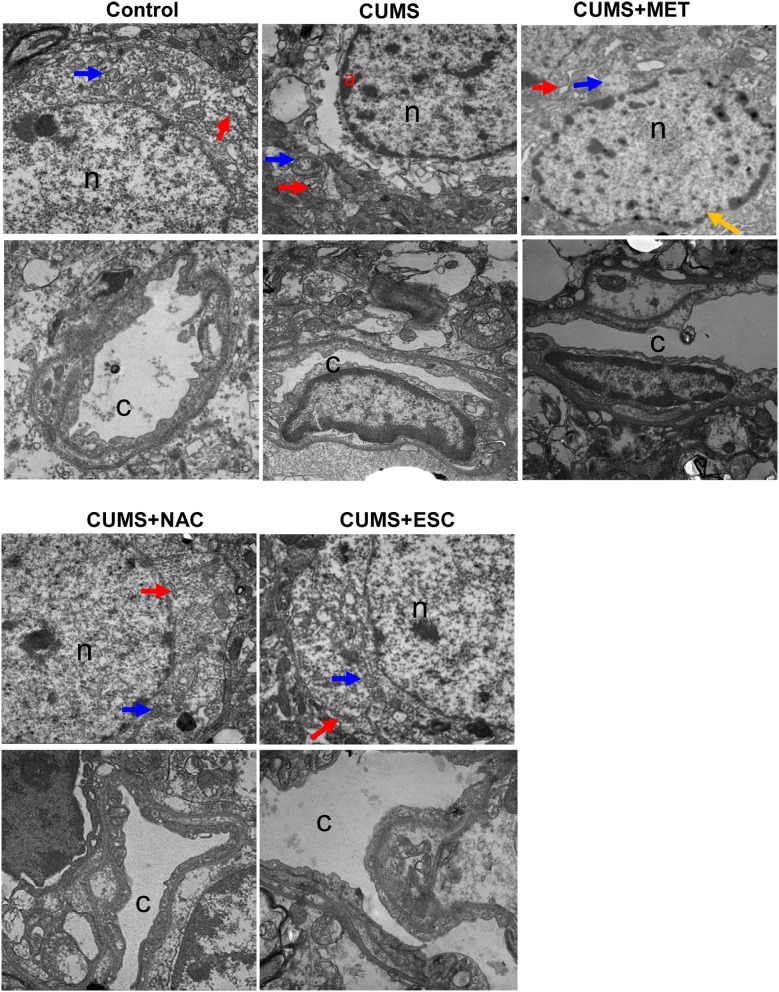
Electron microscope observation of cerebral cortex and hippocampus of rats in each group (×2500). “n” represents for the nucleus, “c” represents for the capillaries, “a” represents for chromatin concentration and edge polymerization, the blue arrow represents for mitochondria, the red arrow represents for endoplasmic reticulum, and yellow arrows represents for chromatin aggregation.